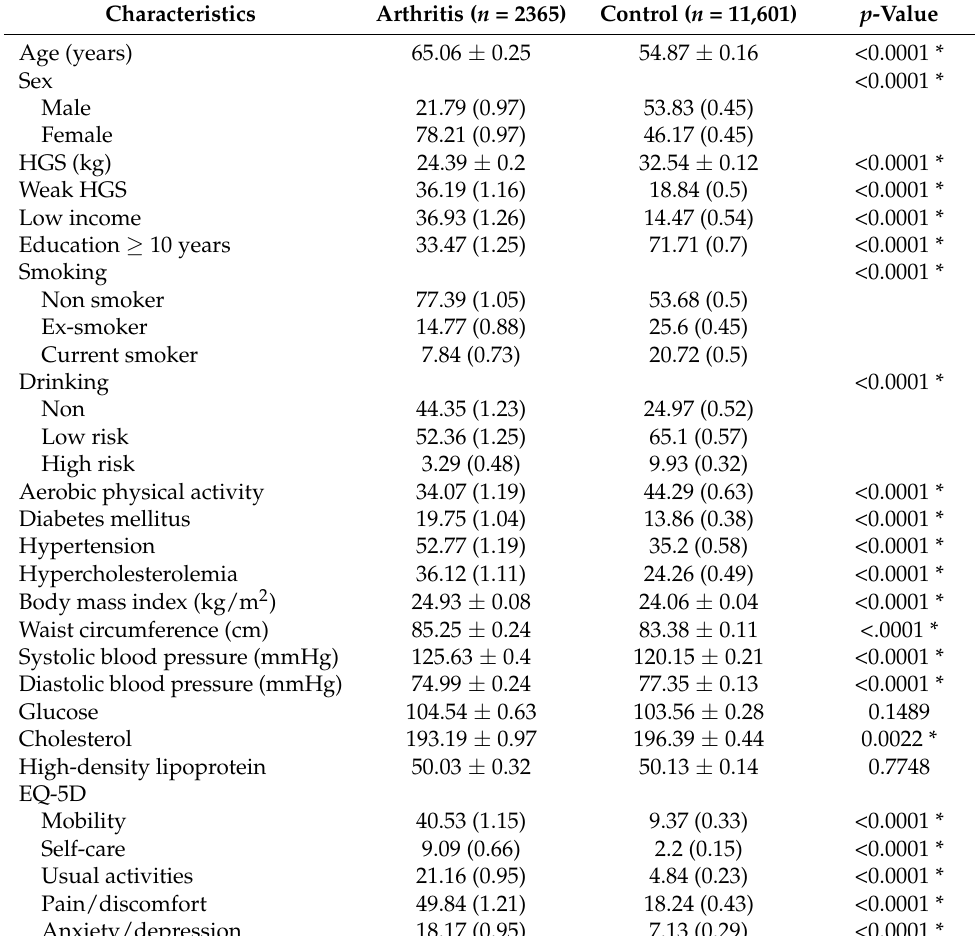
Table 1. Demographic and clinical characteristics of participants.